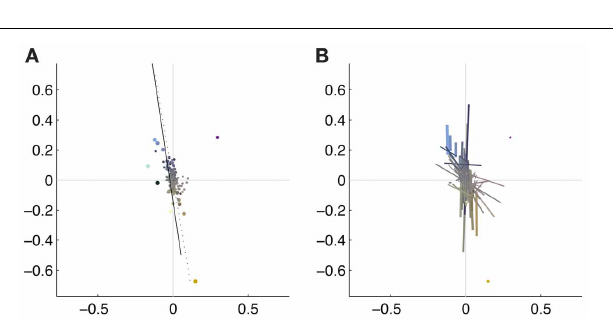
FIGURE 6 | Coverage of color space by basis functions. The thickness of the each dot (A) or line (B) is scaled with the L 2 norm of the basis function, the length of the line corresponds to the eigenvalue obtained from the PCA of the pixels chromaticities (cf. Figure 5 ). The position of the dots and the midpoint of the line indicate the center of gravity. Solid line: daylight axis; Dotted line: direction of first principal component of center of mass